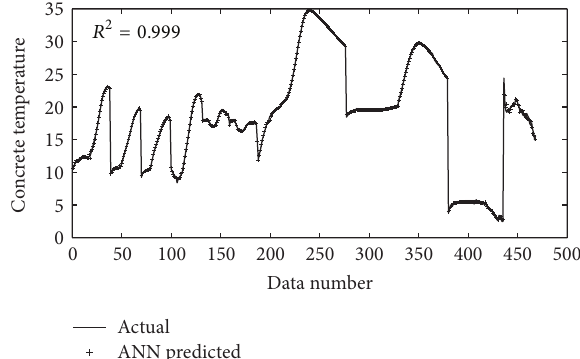
Figure 6: Graphical comparison of temperature with those pre- dicted by ANN in the test